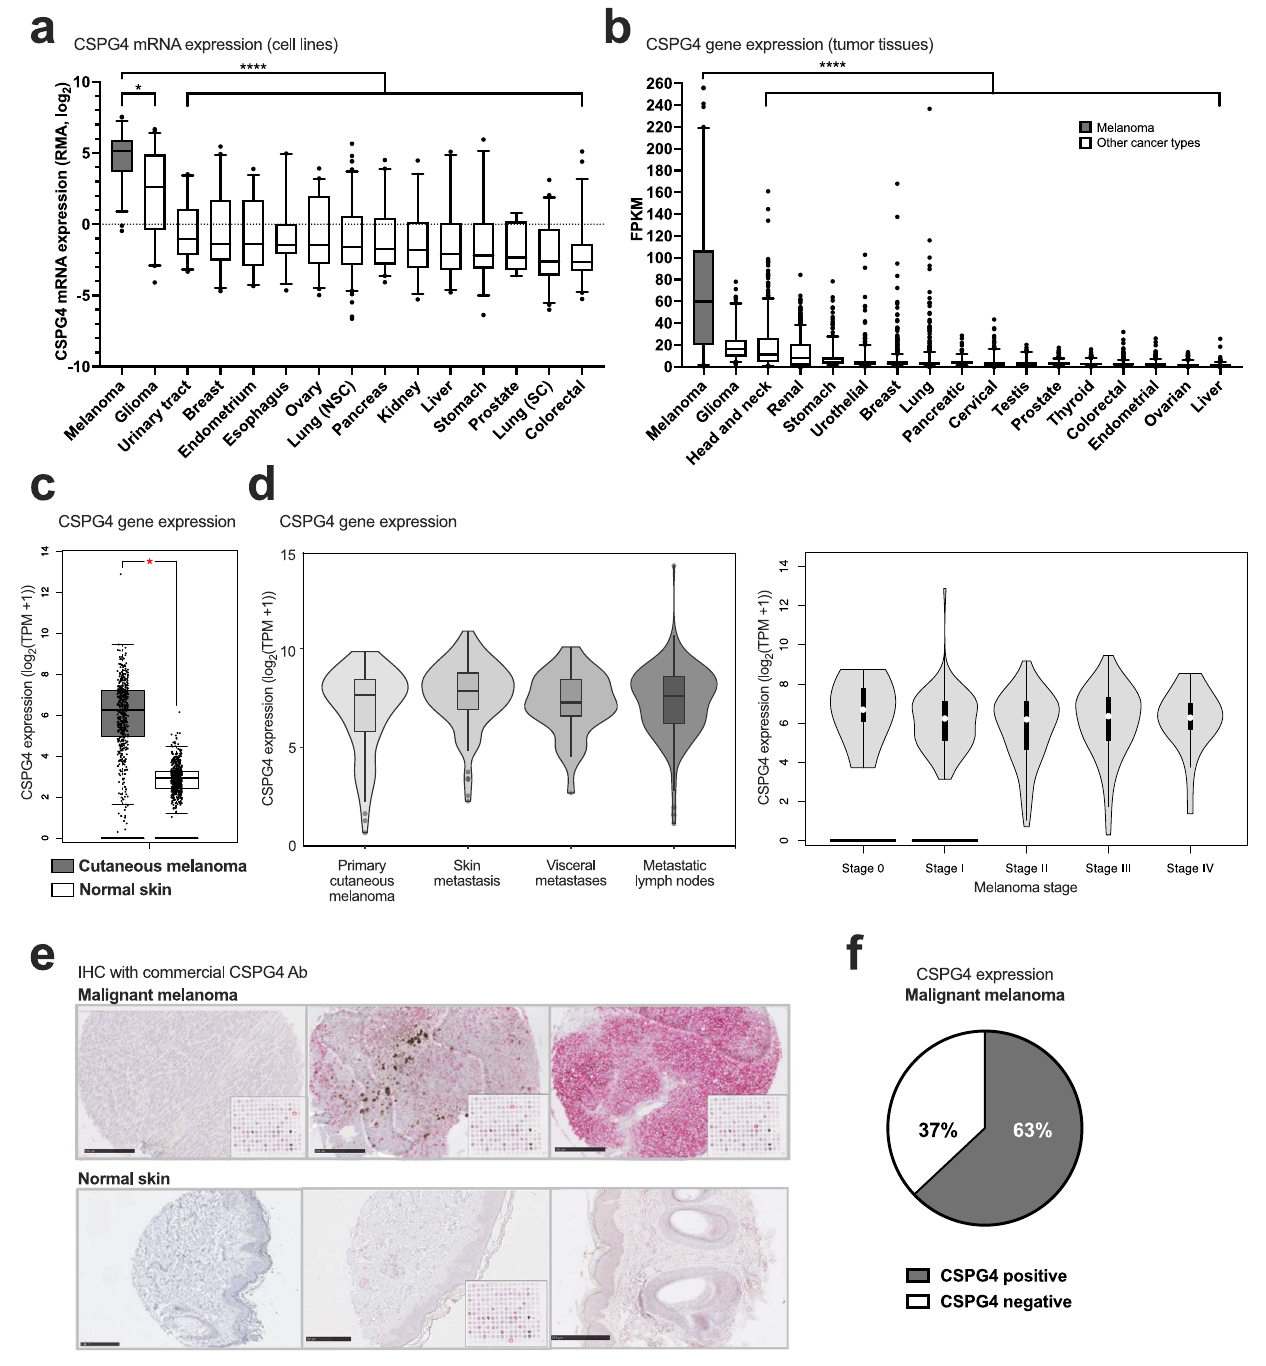
Fig. 1 | CSPG4 expression in malignant melanoma and normal tissues. a CSPG4 mRNA expression, derived from RNAseq data, across cell lines of different cancer cell types. n represents the number of cell lines (data from Cancer Cell Line Ency- clopedia(CCLE),portals.broadinstitute.org/ccle, n =56, n =59, n =26, n =57, n =28, n =27, n =48, n =127, n =41, n =32, n =26, n =37, n =8, n =50, and n =58, respec- tively) ( p =0.0156 and p ≤ 0.0001). b CSPG4 gene expression in tissues across cancertypes (dataand images fromHuman ProteinAtlas, v20.proteinatlas.org 28,29 , n =153, n =499, n =877, n =354, n =406, n =1075, n =994, n =176, n =291, n =134, n =494, n =501, n =597, n =541, n =373, and n =365 samples, respectively per cancer type; p ≤ 0.0001). c Comparison of CPSG4 gene expression between cuta- neous melanoma and normal skin tissues (from GEPIA) 67 ( n =461 and n =558, respectively). TPM=transcripts per million. d CPSG4 gene expression across pri- mary cutaneous melanoma lesions, skin metastases, visceral metastases and metastatic lymph nodes (left; TCGA-SKCM data was obtained from